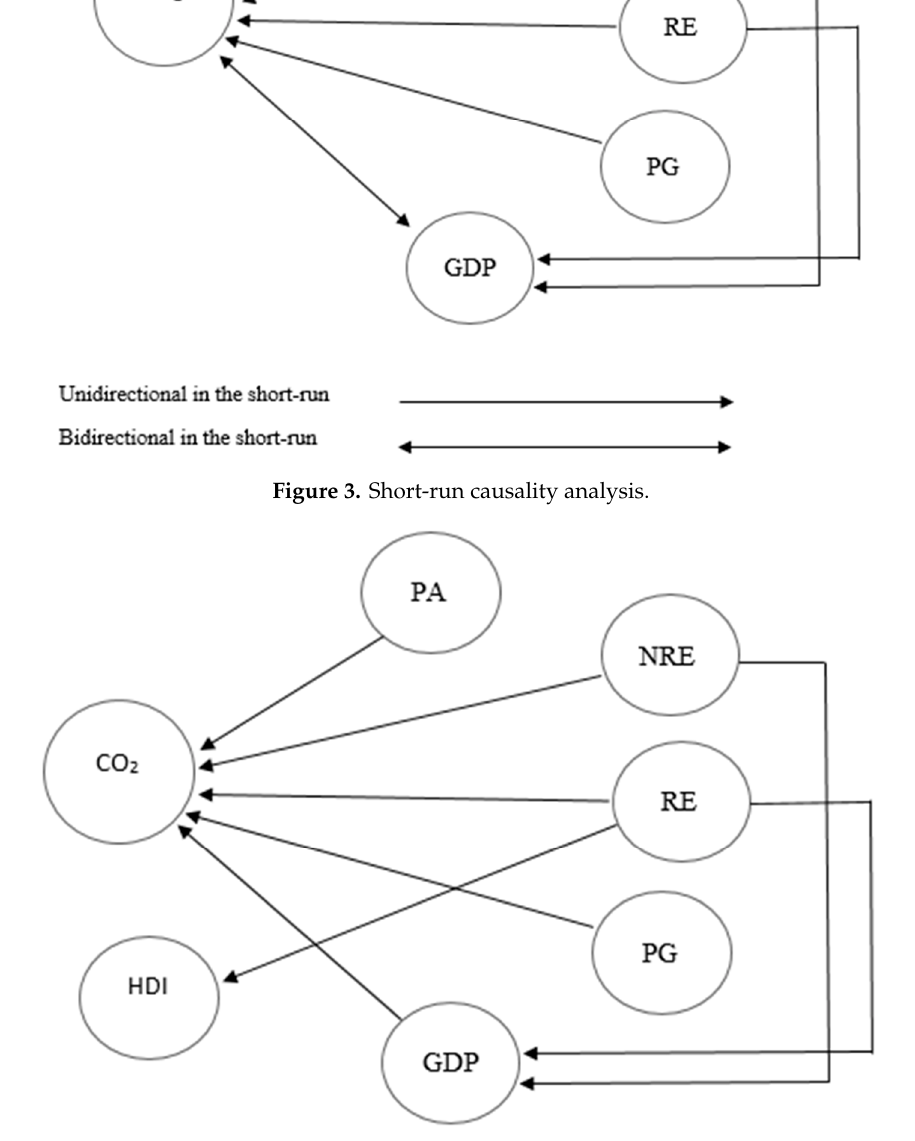
Figure 4. Long-run causality direction.